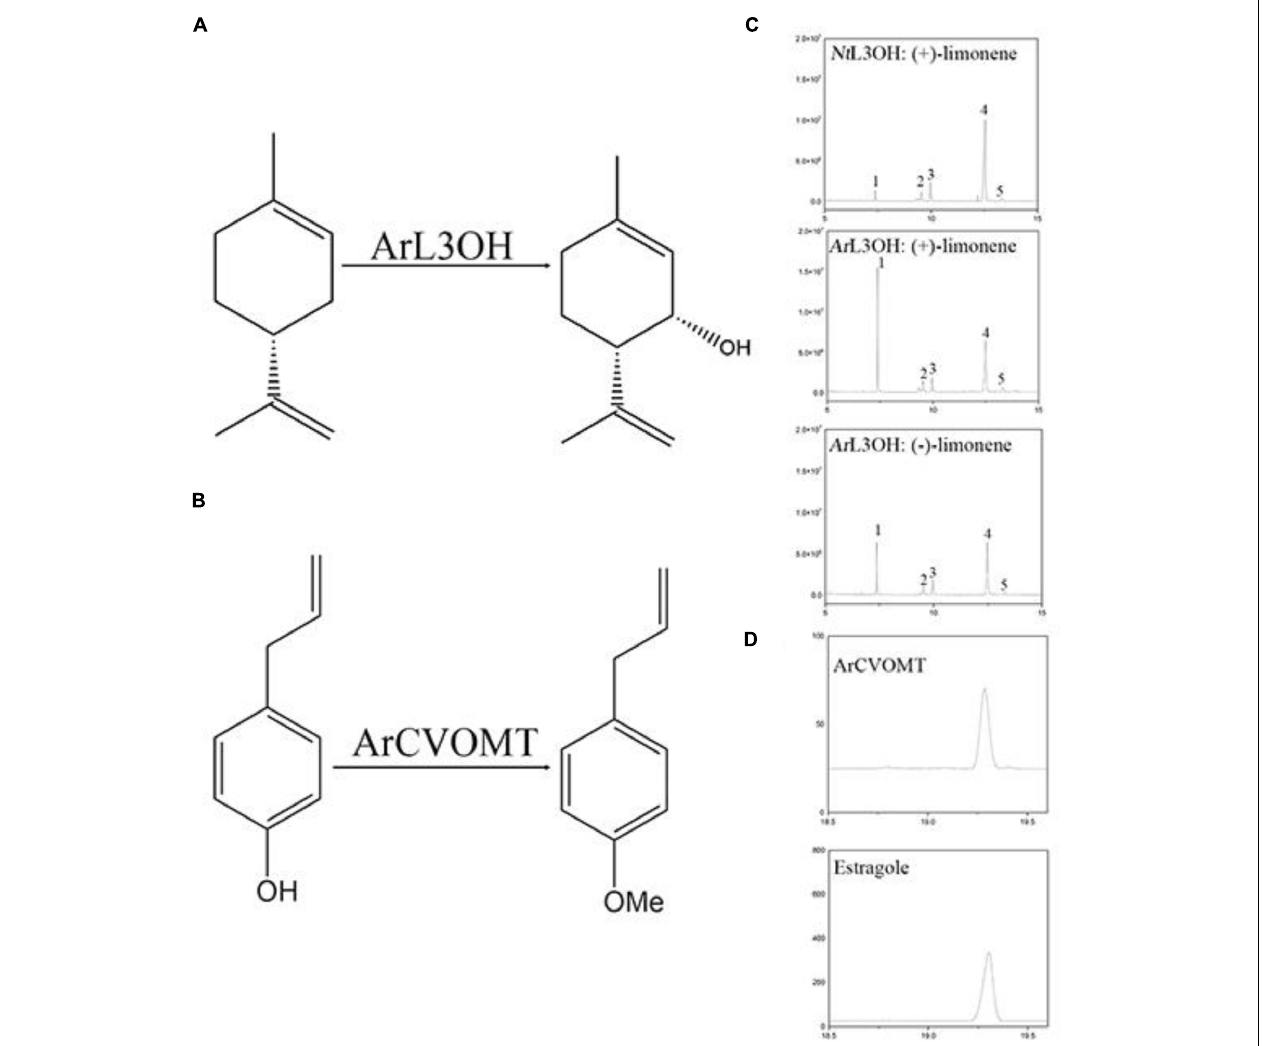
FIGURE 5 | Functional characterization of L3OH and CVOMT. (A) Reaction of limonene to isopiperitenol catalyzed by limonene-3-hydroxylase from A. rugosa . (B) The reaction of chavicol to estragole catalyzed by chavicol menthyl transferase. (C) GC chromatograms of products from Nt L3OH and Ar L3OH with limonene. 1, the peak of limonene; 2, the peak of C1-OH product; 3 and 4, unknown; 5, the peak of tenol. (D) A GC chromatogram of products from CVOMT with chavicol; b, GC chromatograms of the standard of